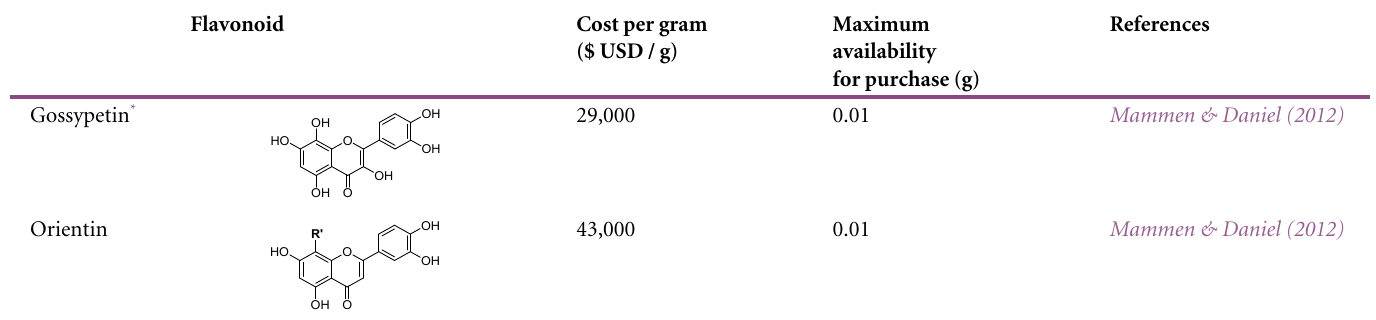
Table 2. Cost and availability of Al 3+ chelating flavonoids (Sigma Aldrich, August 2021) Flavonoid